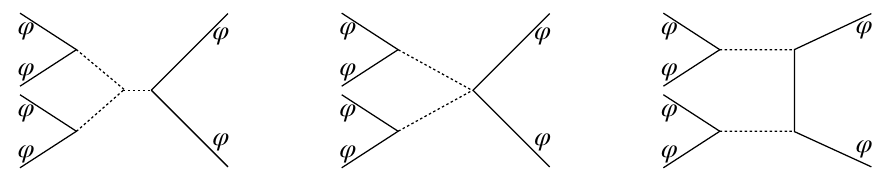
Figure 5 . The leading order Feynman diagrams of six-point scattering of ϕ